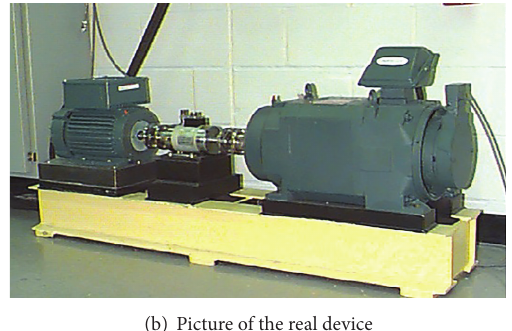
Figure 4: The schematic diagram and a picture of the device. −1.5−1−0.500.511.52